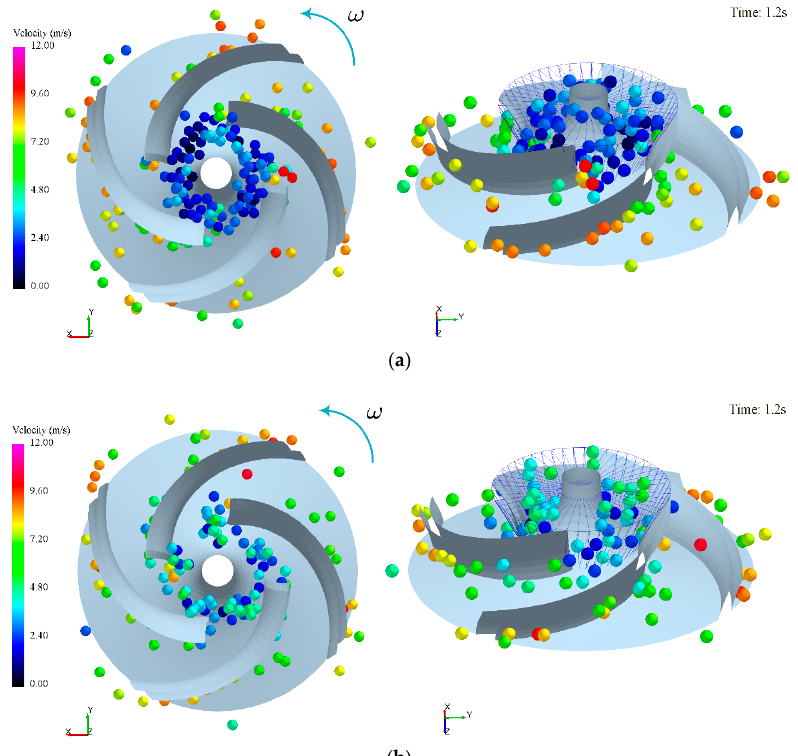
Figure 11. Color indicates the velocity of particles: ( a ) particles in the first stage impeller; ( b ) particles in the second stage impeller.